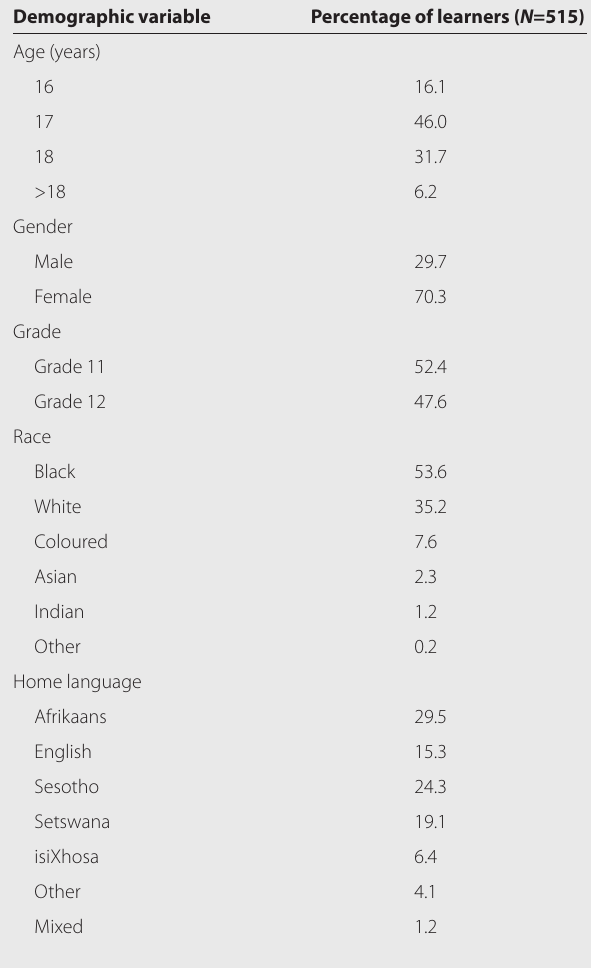
Table 1. Demographic data of